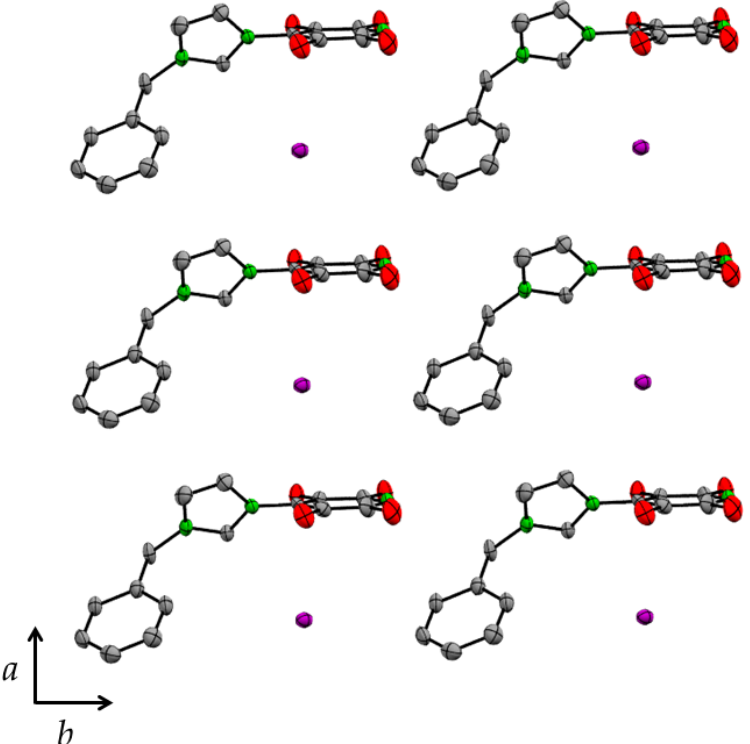
Figure 5. Crystal structure of 1-(2,3,5,6-tetrafluoro-4-pyridyl)-3-benzylimidazolium iodide ( 3 ) view parallel to the c axis. Thermal ellipsoids are at the 50% level. Hydrogen atoms are omitted for clarity.